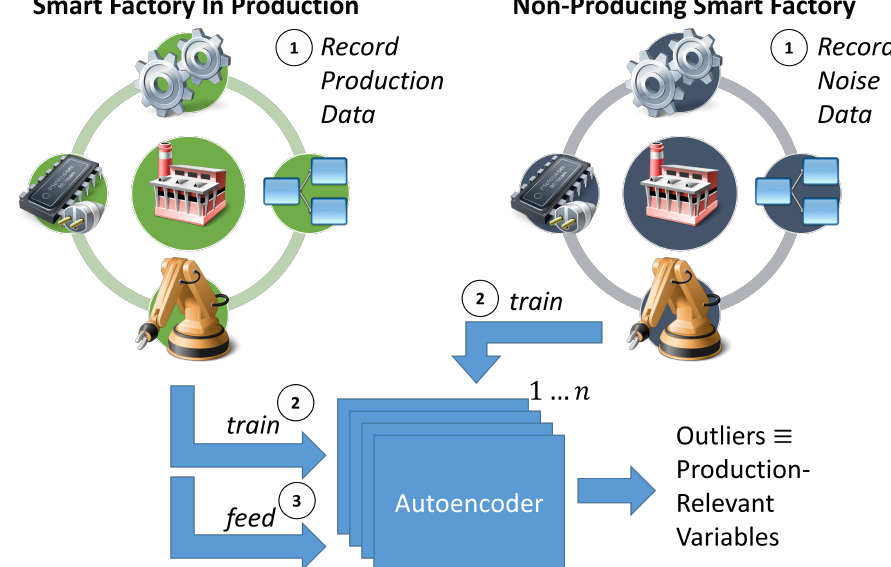
Figure 2. Overview flowchart of the training and selection process. (1) The smart factory is recorded twice: in production and non-producing. (2) The AEs are trained on the recordings. (3) Production data are fed to the AEs to detect production-relevant